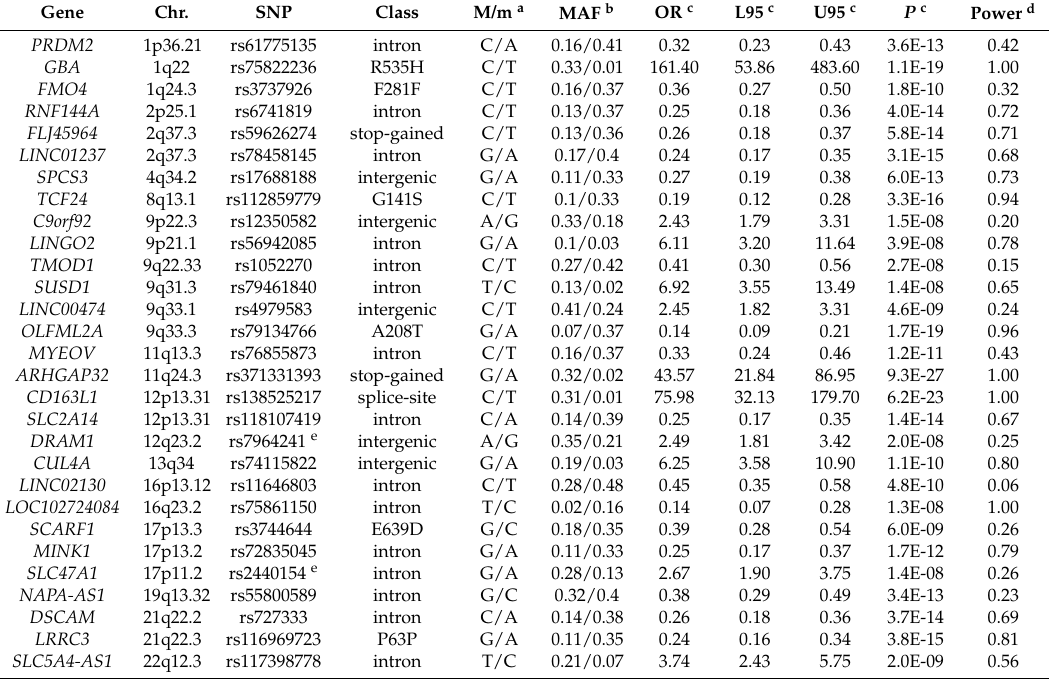
Table 2. Genome-wide associations of 29 SNPs with intracranial